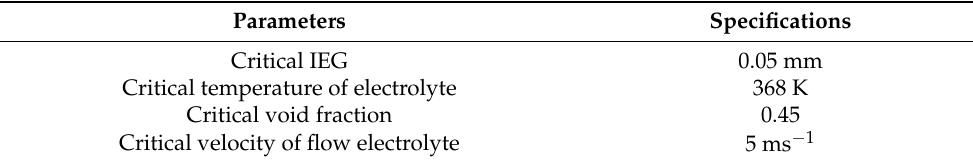
Table 1. Critical values of adaptive control